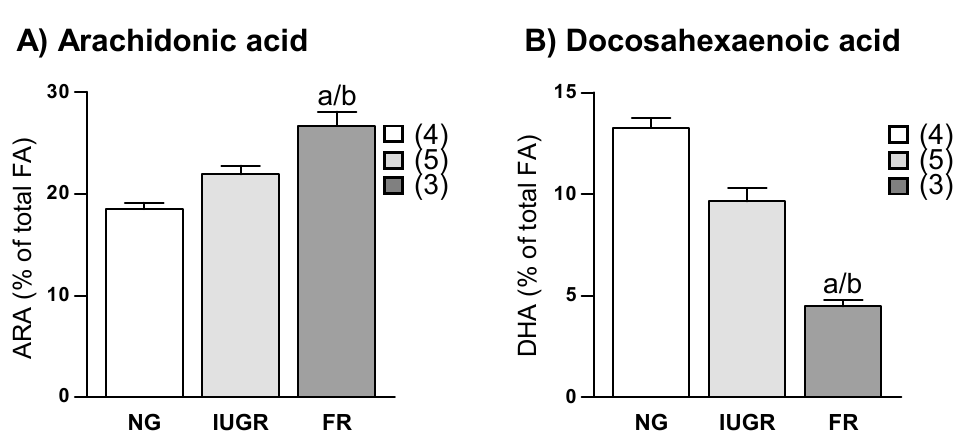
Table 1. Fetal anthropometric parameters.